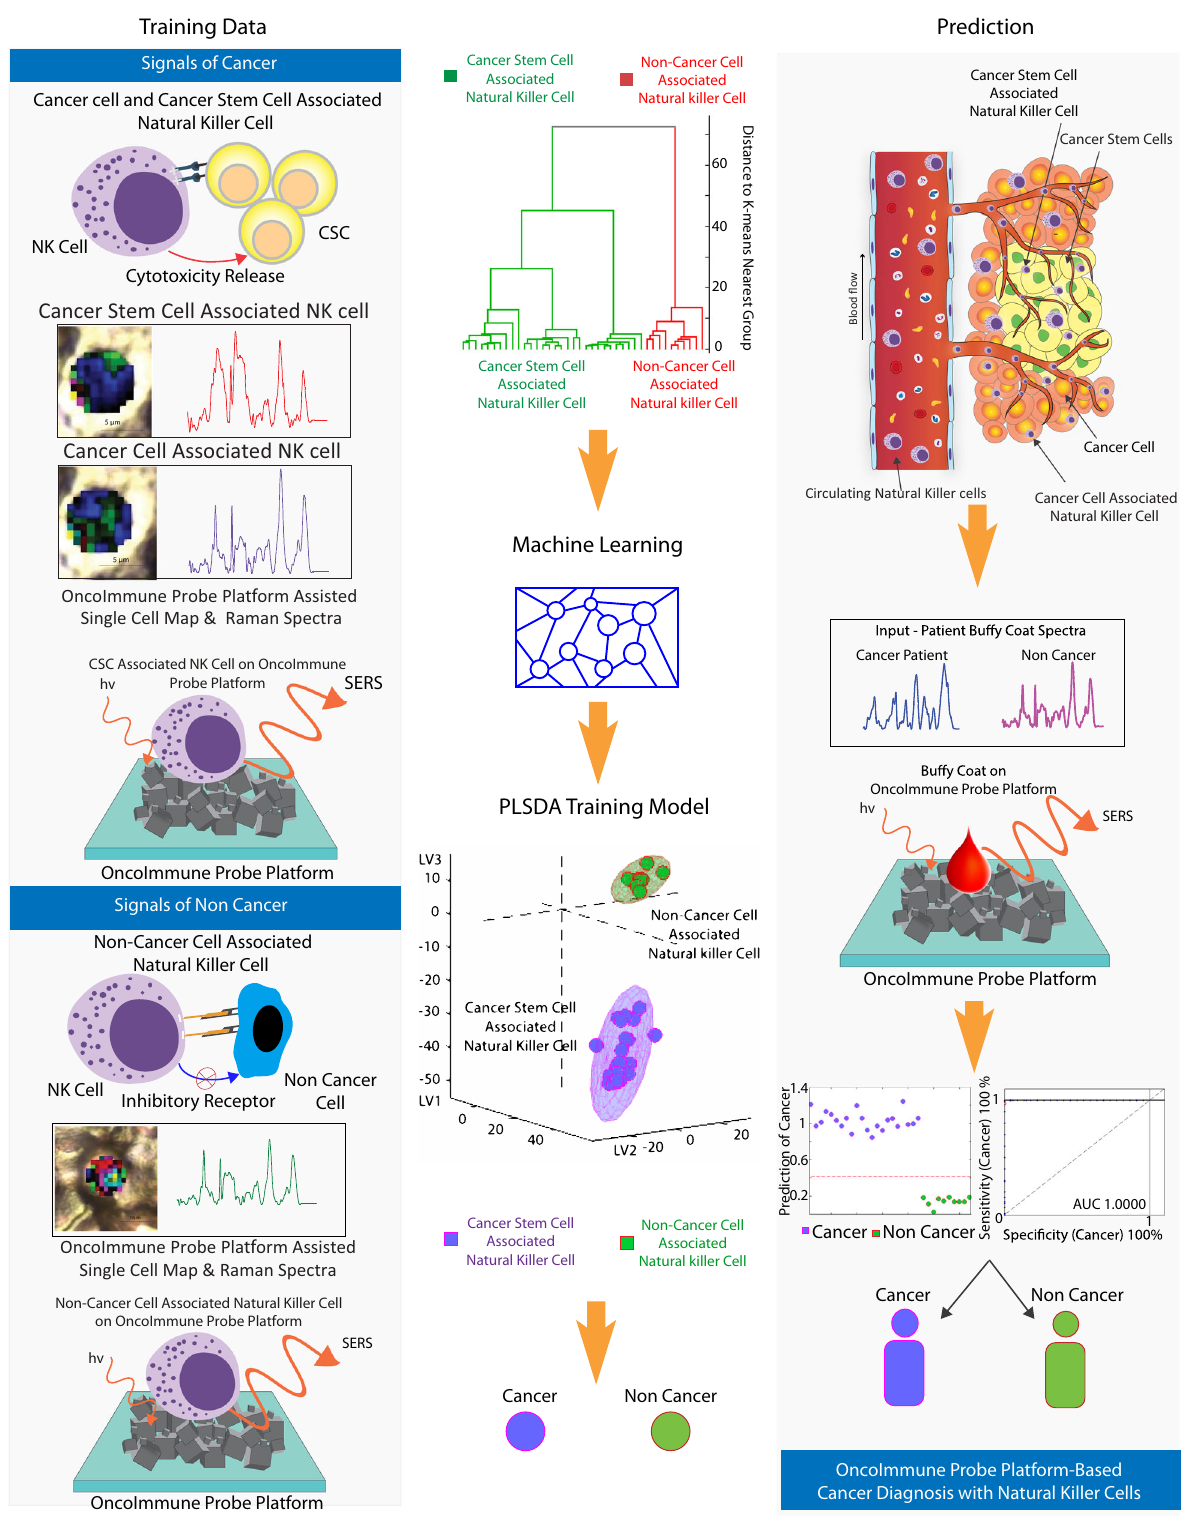
Fig. 1 | Schematic representation of working of circulating natural killer (NK) cell pro fi ling (CKNP) with OncoImmune probe platform. Left panel demon- strates training dataset collection with tumor (cancer — purple spectra and CSC- associated NK cell — red spectra) and non-cancer-cell-associated NK cell Raman pro fi le — green spectra. Middle panel demonstrates model learning. Exploratory analysis with K-means clustering was performed. PLSDA (Partial Least Squares